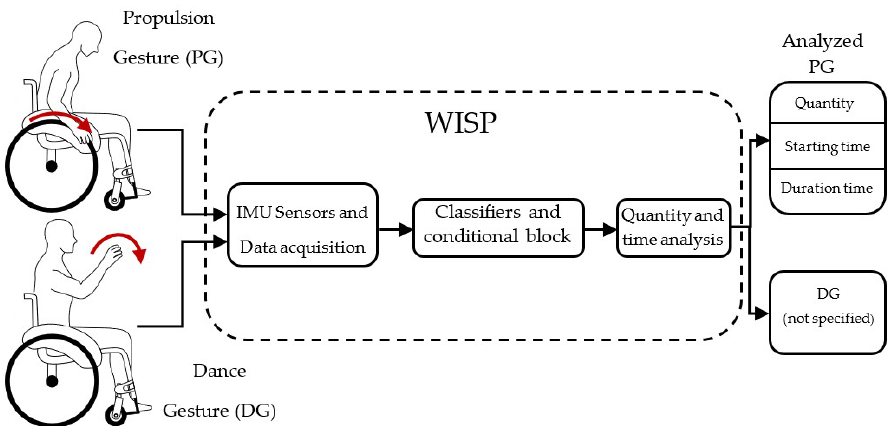
Figure 1. Raw acceleration and angular velocity are read from IMU sensors during propulsion and dance gesture performance. The data extracted are treated and classified by the machine learning classifier algorithm and it provides analyzed data for manual wheelchair dance assessment.